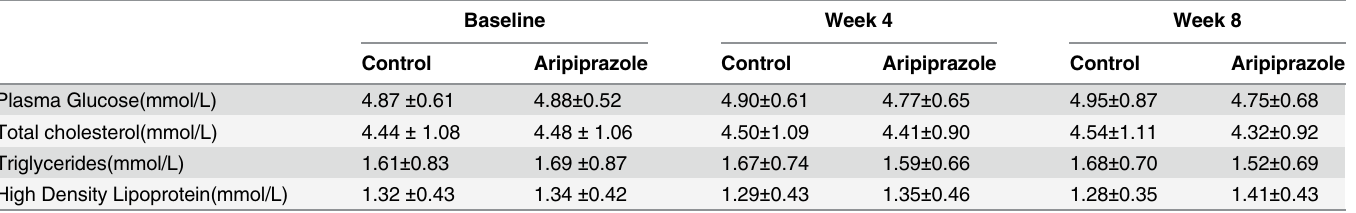
Table 2. Changes in plasma glucose, Total cholesterol, Triglycerides,and High Density Lipoprotein after additional treatment aripiprazole. Values are mean ±